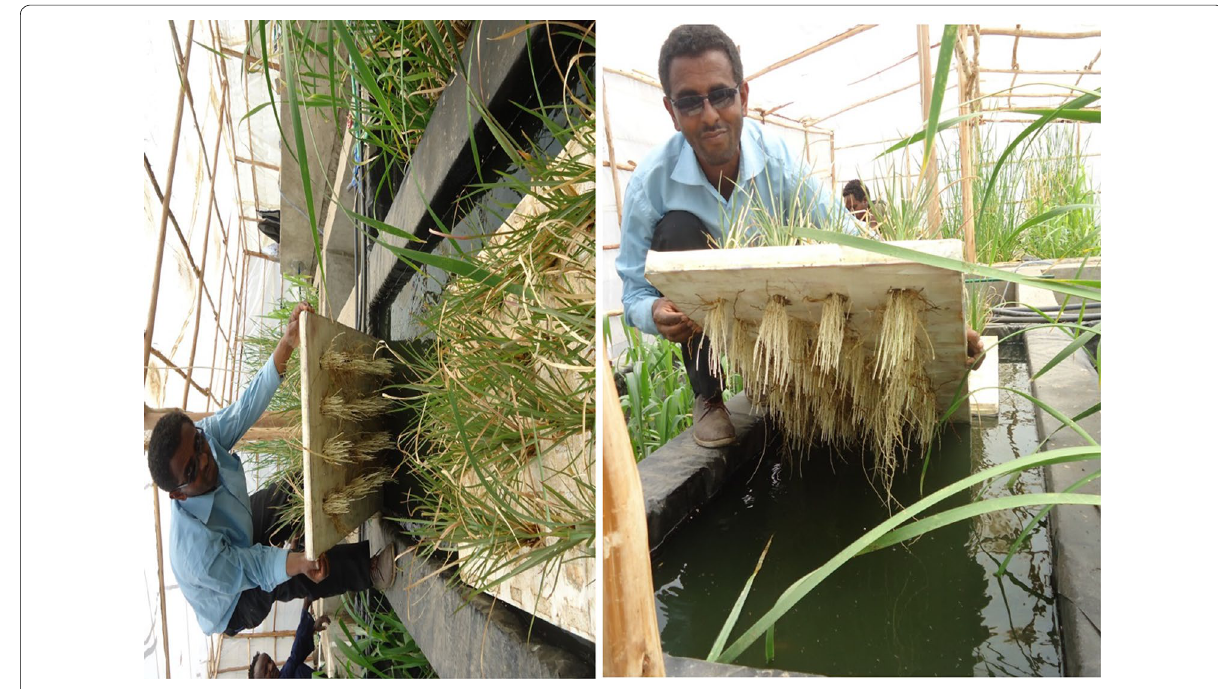
Fig. 3 Shoot and root growth of vetiver grass after transplantation of 5